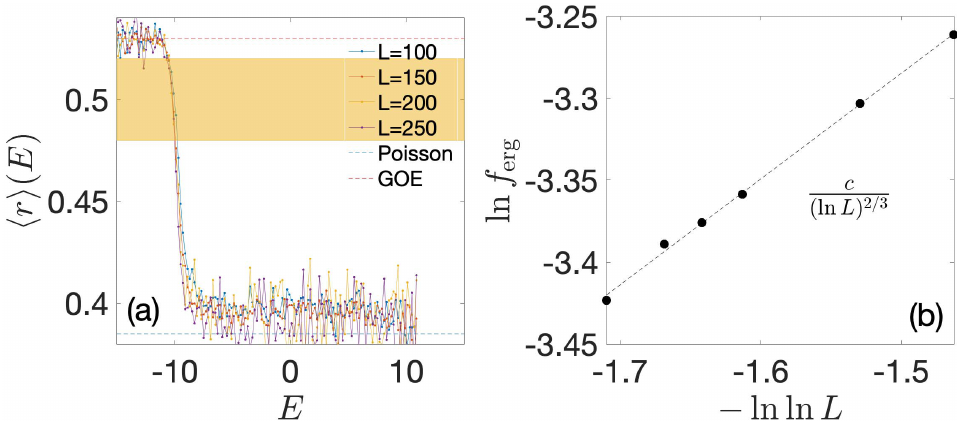
Figure 9: Threshold analysis of ratio r -statistics versus the energy E . (left) Energy-resolved 〈 r 〉 ( E ) for the disorder strength W = 10, a = 1.5, and β = 0.3 for different system sizes L = 100, 150, 200, and 250 with the corresponding num- ber of disorder realizations 1000, 1000, 150, and 50, respectively. Dashed horizontal lines show the limiting ergodic ( r (cid:39) 0.53) and Poisson ( r (cid:39) 0.386) values. The or- ange shaded region shows the threshold r ∈ [ 0.48,0.52 ] used for the extraction of the fraction f of the ergodic states in the main text. (right) Fraction f of ergodic erg erg extended states below the finite-size mobility edge, E < − E ∗ < 0, extracted from the data in the left panel in the localized phase, a = 1.5, β = 0.3, versus the system size L . The number of disorder realizations is from 2000 for L ≤ 100 to 150 for L = 250. Numerical f (symbols) is consistent with analytical predictions (dashed erg line) in (23).